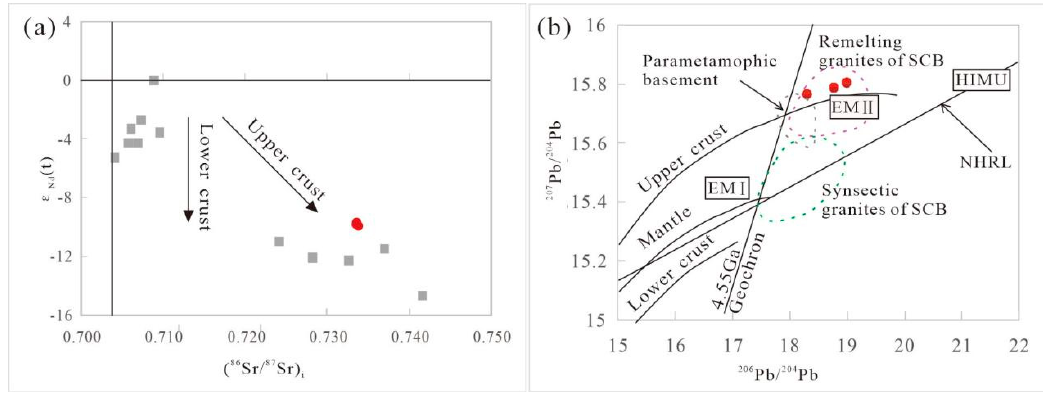
Figure 9. Diagrams of ( 87 Sr / 86 Sr) i - ε Nd(t) ( a ) and Pb-isotopic composition ( b ) of biotite granite obtained Fig.9 Diagrams of ( 87 Sr/ 86 Sr) i - ε Nd (t) (a) and Pb-isotopic composition (b) of biotite monzogranite obtained from the Lincang